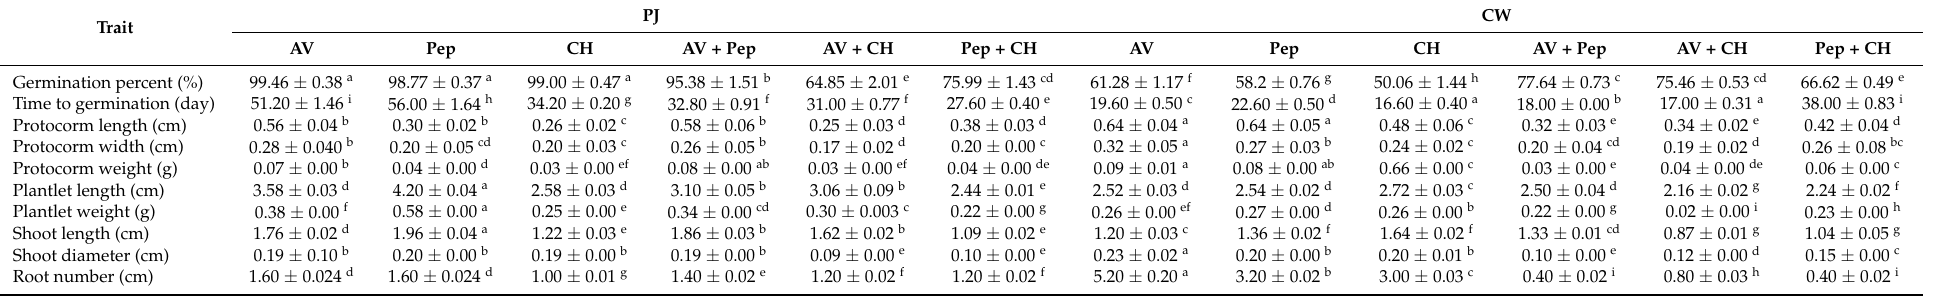
Different letters in each row indicate significance by LSD tests at p < 0.05. Values represent the means ± standard